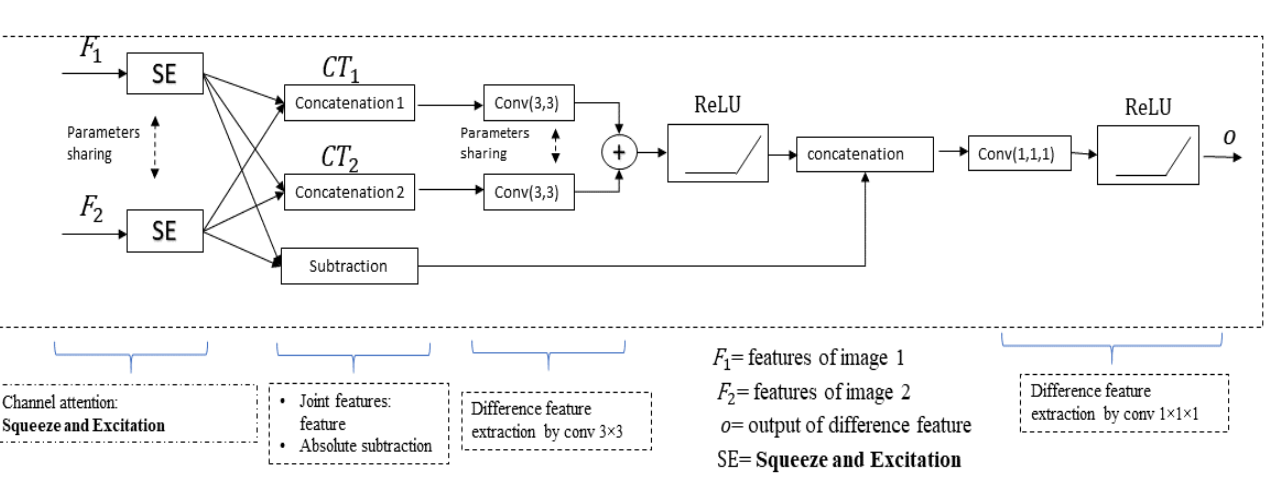
Figure 3. Block diagram of the proposed dissimilarity attention gate (DAG).